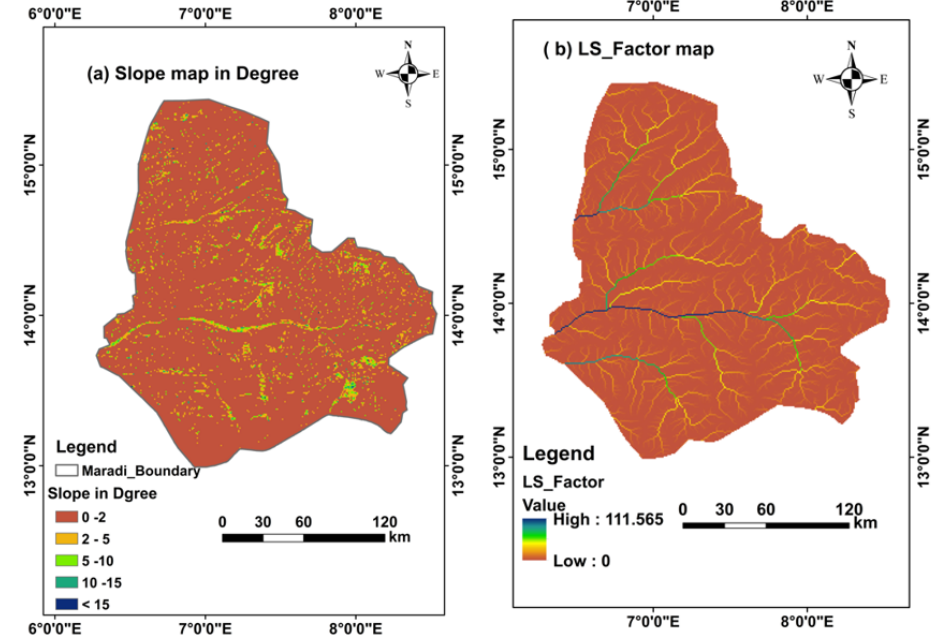
Figure 5. Slope map ( a ) and slope length and steepness (LS-factors) ( b ).